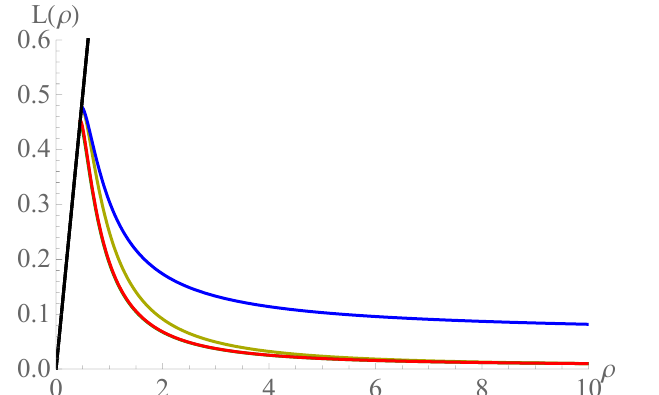
Figure 15. SU(4) 2 F, 2 ¯ F, 4 A 2 — We display the vacuum solutions L ( ρ ) : the gold line corresponds to the A 2 representation and the red is the F. The blue line is the fundamental when we consider an additional NJL-term such that it matches in the IR the A 2